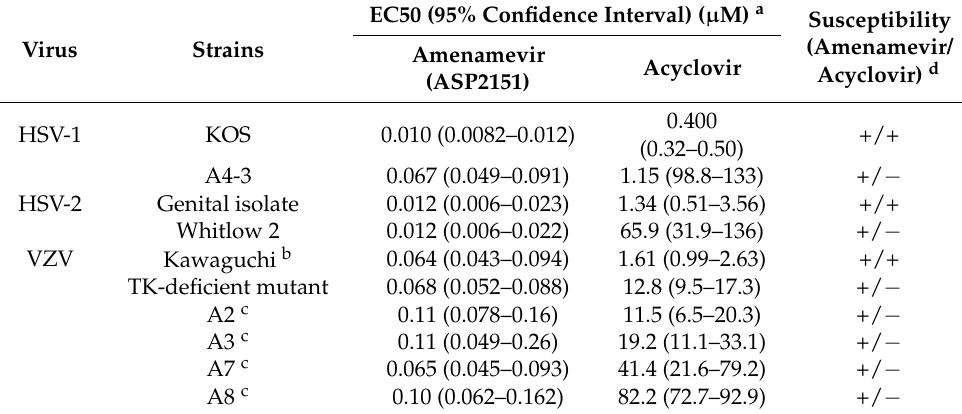
Table 2. EC 50 values of ASP2151 and ACV against ACV-resistant or ACV-susceptible HSV-1, HSV-2, and VZV strains (plaque reduction assay)